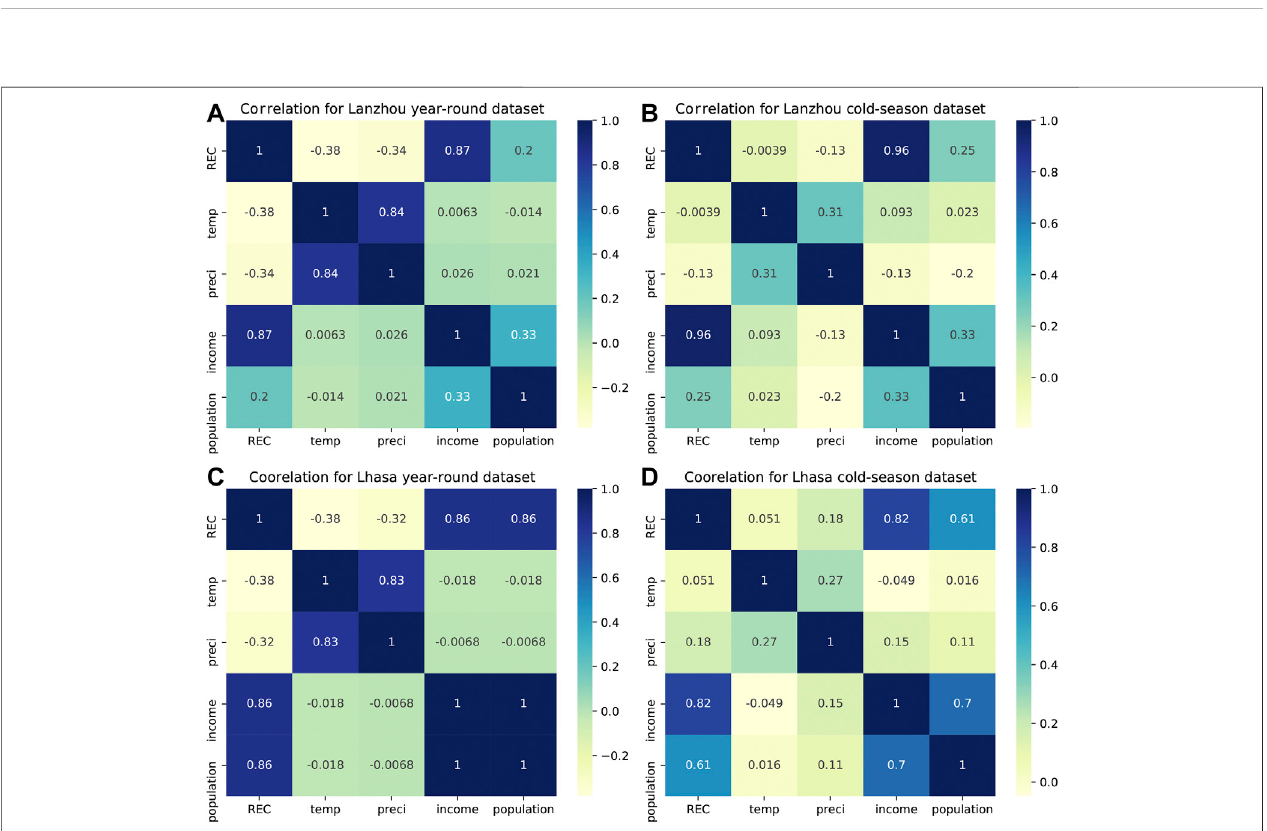
FIGURE 5 | Correlation heat maps of the 2011 – 2019 Lanzhou and 2014 – 2019 Lhasa data. Correlations among the data variables in the Lanzhou (A) year-round and (B) cold season datasets and correlations for the Lhasa (C) year-round and (D) cold season datasets. (REC - residential electricity consumption).